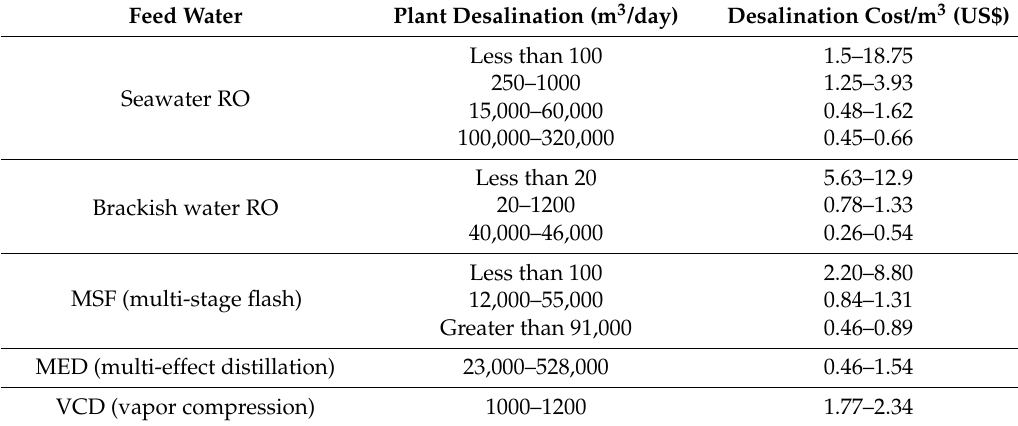
Table 1. Membrane vs thermal desalination cost per feed water source and production capacity, adapted from [148].